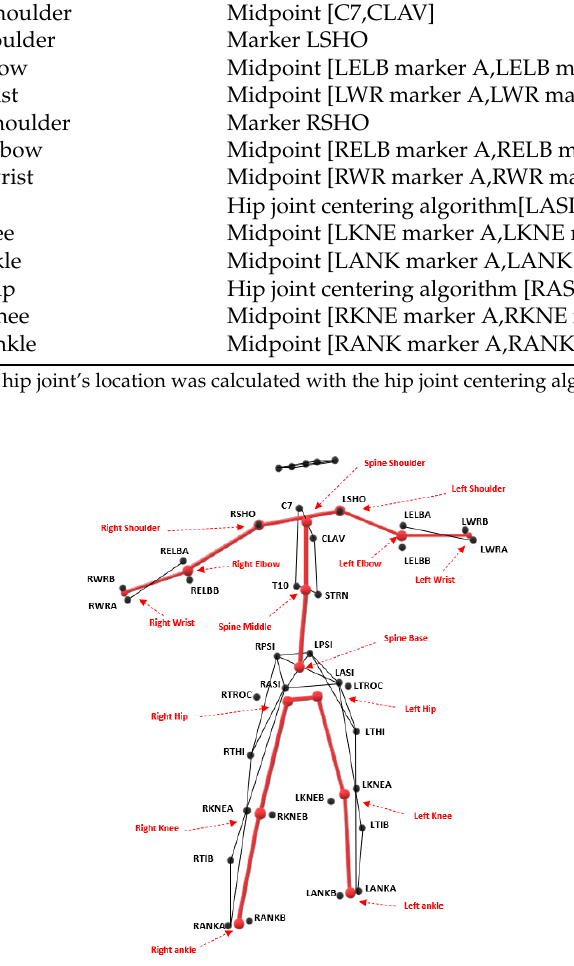
Figure 2. The Kinect V2 skeleton model built from Vicon